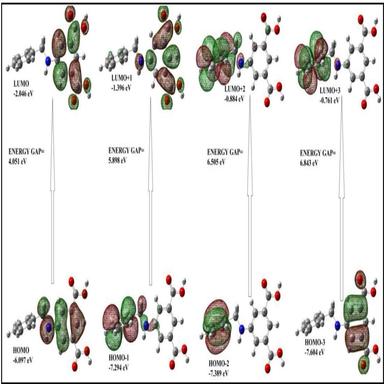
HOMO-LUMO diagrams with band gap energy.